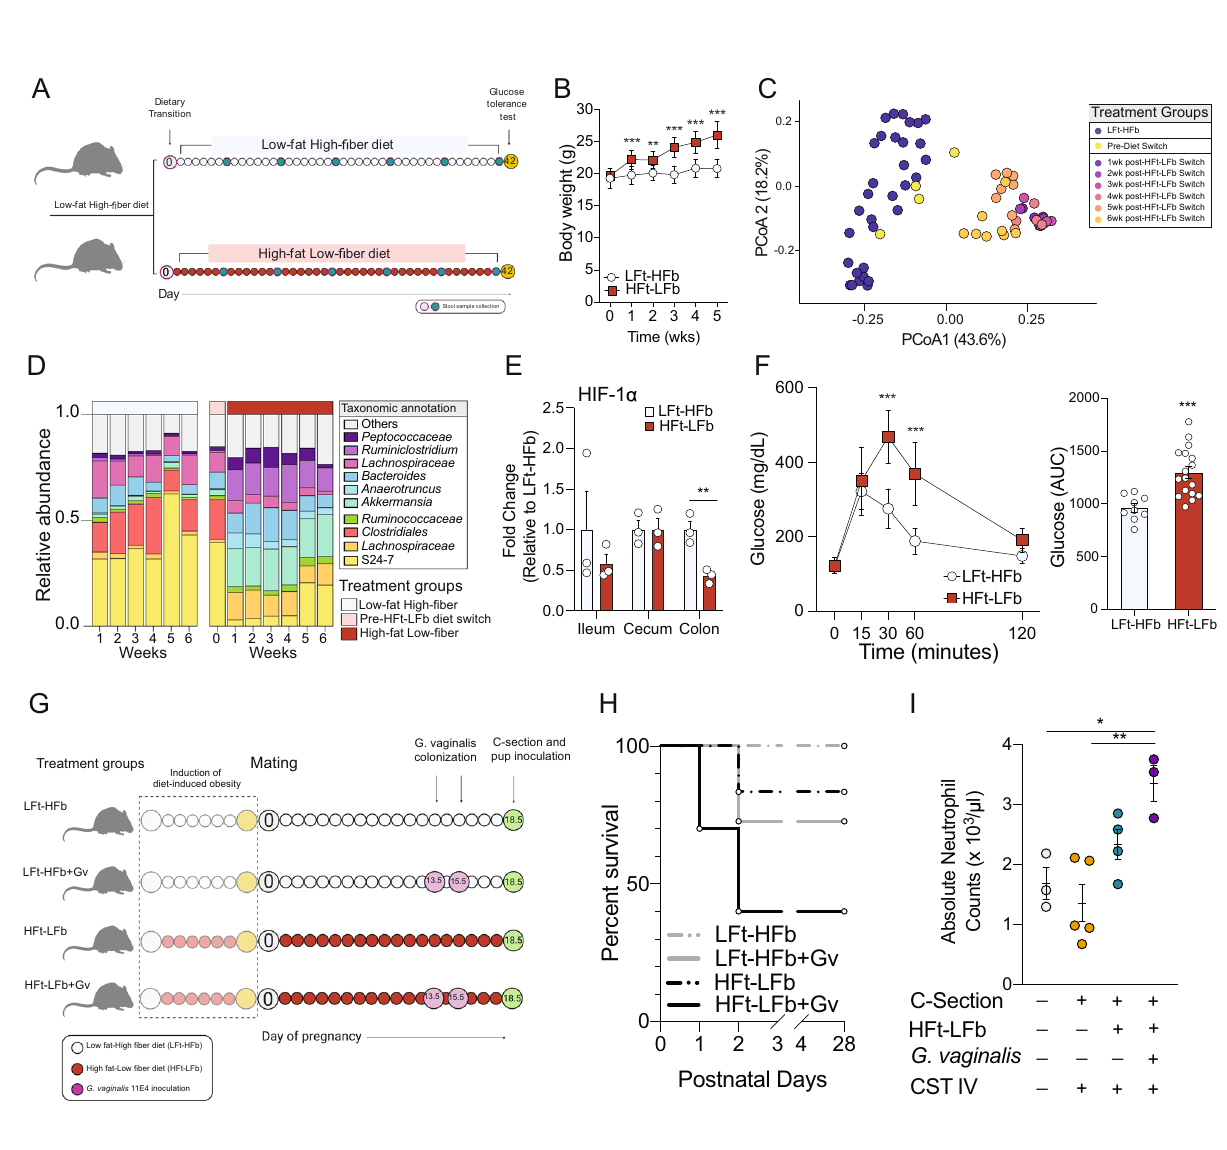
Fig. 2 Transcriptional landscape of the neonatal ileum and the circulating immune compartment is in fl uenced by vaginal community state type. A Schematic of experimental outline to determine the in fl uence of the human microbiome on transcriptional pro fi les of the neonatal ileum and the circulating immune compartment. Created with BioRender.com. B Principal component analysis plots of gene expression data demonstrating the distribution of P1 male ileum samples colored by treatment group, revealing clustering is driven by developmental maturity, mode of delivery, and colonization (C-section Amies inoculated vs. vaginally delivered) and the C-section pups inoculated with human vaginal microbiota as an intermediate between the Amies and vaginally delivered pups. P1 corresponds to 24 hrs post-inoculation. N = 3 – 4 males per treatment. C Heatmap depicting mean expression of genes in the ileum P1 males, showing differences between CST I and CST IV males (linear fi t model, FDR < 0.1, log(FC) = 1.5). Unbiased hierarchical clustering showing similarity in transcriptional patterns between CST IV and VD males, and CST I and Amies males. P1 corresponds to 24 h post-inoculation. Color based on row Z -scores for each gene. Three clusters of differentially regulated genes in each treatment group are indicated. N = 3 – 4 males per treatment. D Cluster- based functional enrichment analysis of differentially expressed genes in the ileum of P1 males showing signi fi cant enrichment of pathways involved in defense response to bacteria, innate immune activation, chemotaxis, and mucus secretion in the ileum of CST IV relative to CST I inoculated males (FDR < 0.05). Bubble plot size denotes enrichment. N = 4 – 6 males per treatment. E t-SNE visualization demonstrating CyTOF phenotyping of CD45 + immune cells in whole blood of CST I, CST IV, and vaginally delivered males showing neutrophils as the major immune subset in the circulating immune compartment at P1 (equal sampling across treatment groups, total 10,000 events). P1 corresponds to 24 h post-inoculation. N = 3 males per treatment. F Average frequencies of major leukocytes within whole blood in P1 CST I, CST IV, and VD males. N = 3 males per treatment. G – L Frequencies of circulating ( G ) neutrophils, ( H ) monocytes, ( I ) MHC II + B cells, ( J ) MHC II - B cells, K CD8 + T cells, and L CD4 + T cells within whole blood in P1 CST I, CST IV, and VD males. (1) Frequency of CD4 + T cells were signi fi cantly increased in VD males compared with CST I and CST IV males (One-way ANOVA, F 2,6 = 15.97, P = 0.0040; Tukey ’ s post-hoc CST I vs. VD P = 0.0072; CST IV vs. VD P = 0.0059). N = 3 males per treatment. Data represented as mean ± SEM with individual data points overlaid. ** P <